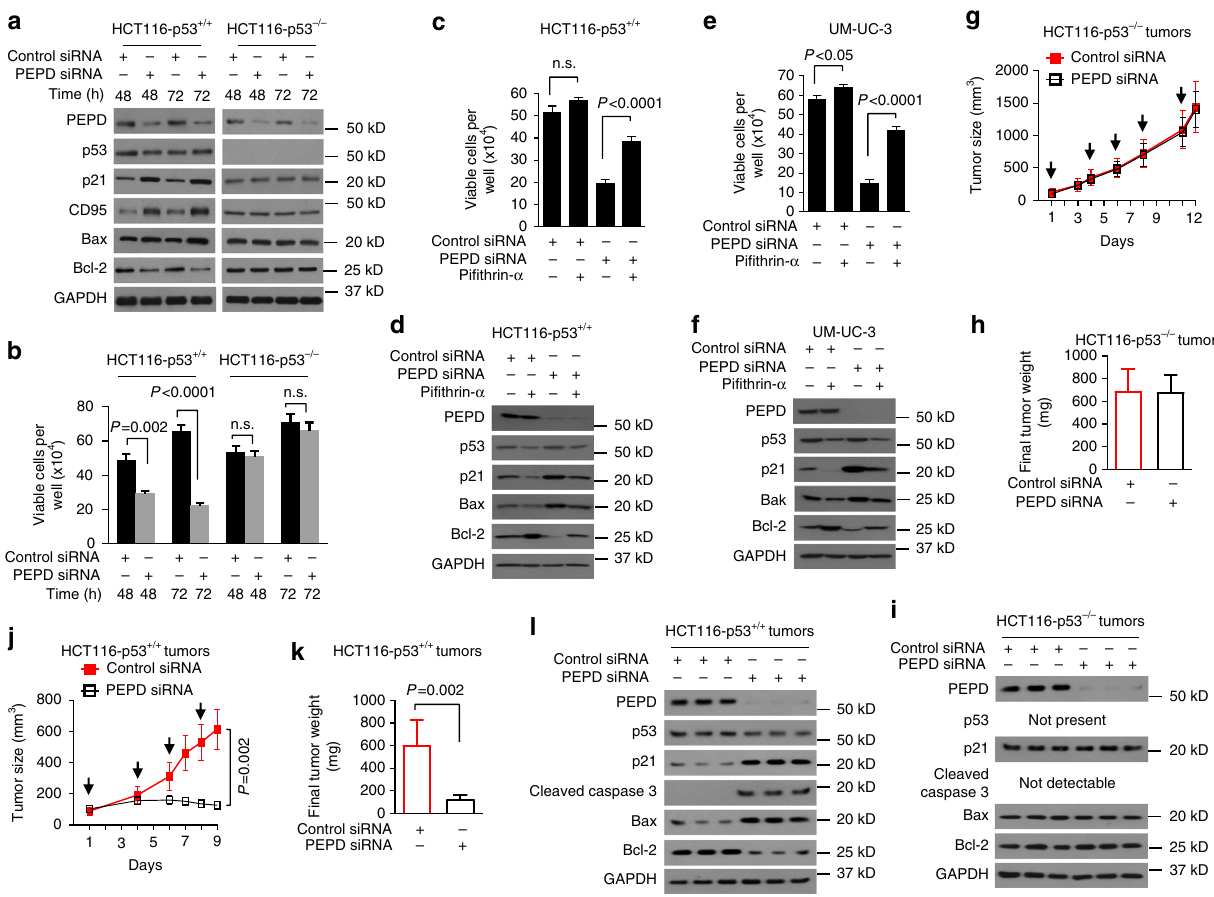
Fig. 2 PEPD protects cells by suppressing p53. a , b IB analysis of various proteins and measurement of cell viability after siRNA treatment. c – f Measurement of cell viability and IB analysis of proteins after treatment with siRNA in the absence or presence of pi fi thrin- α (30 μ M) for 72 h. g – i HCT116- p53 − / − tumor growth in athymic nude mice after intratumoral injection of control siRNA or PEPD siRNA at the indicated times (arrows), fi nal tumor weight, and IB analysis of various proteins in 3 tumors per group obtained on day 12. j – l HCT116-p53 +/+ tumor growth in athymic nude mice after intratumoral injection of control siRNA or PEPD siRNA at the indicated times (arrows), fi nal tumor weight, and IB analysis of various proteins in 3 tumors per group obtained on day 9. Cells were grown in 12-well plates (2 × 10 4 cells/well) for 24 h before experimental treatment in a – f . Data are means ± s.d. ( n = 3) in b , c and e (two-way ANOVA followed by Tukey multiple comparisons test) and means ± s.e.m. ( n = 7 – 8) in g , h , j , and k (two-tailed t -test); n.s., not signi fi cant. GAPDH was used as a loading control in the IB